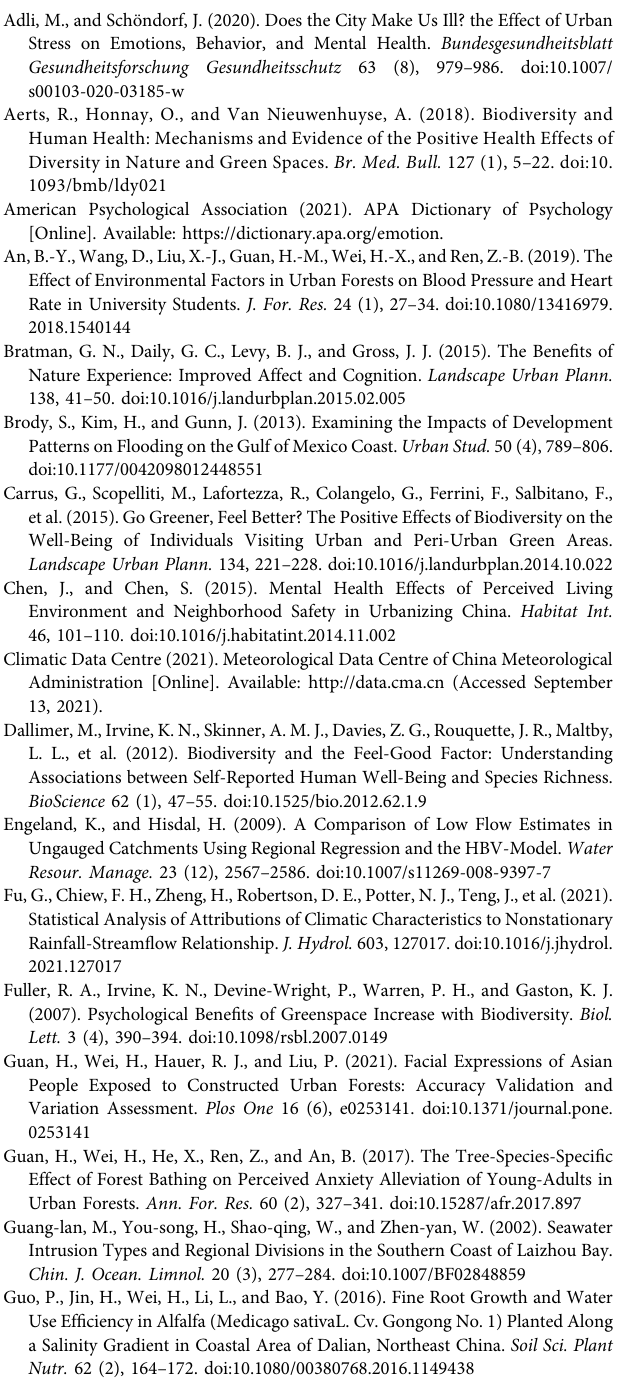
Figure S2 | Correlations between paired variables among parameters about topography (longitude and latitude), socio-economy (population, GDP, administrative area [Aarea], and the distance of objective park to downtown of host-city [Distance]), and meteorological records (temperature [T], rainfall [rain], relative humidity [RH], and wind velocity